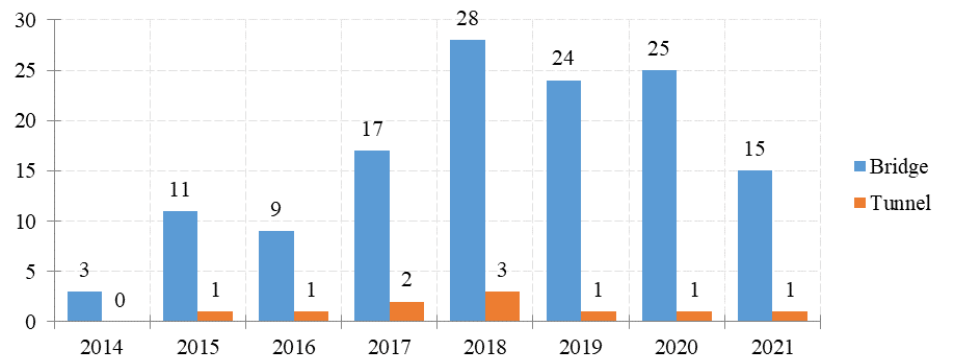
Figure 1. Number of documents published through the years concerning bridge and tunnel inspections using